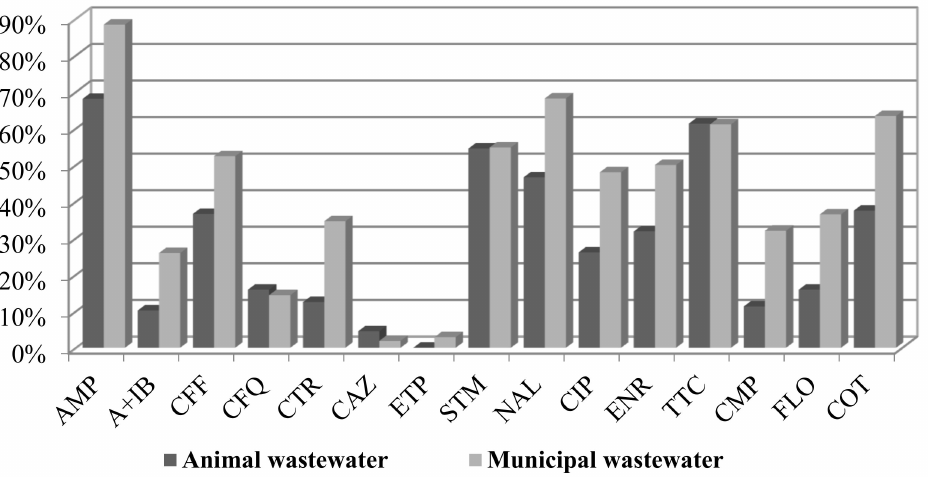
Figure 1. Percentage of resistance of E. coli strains isolated from animal and municipal wastewater